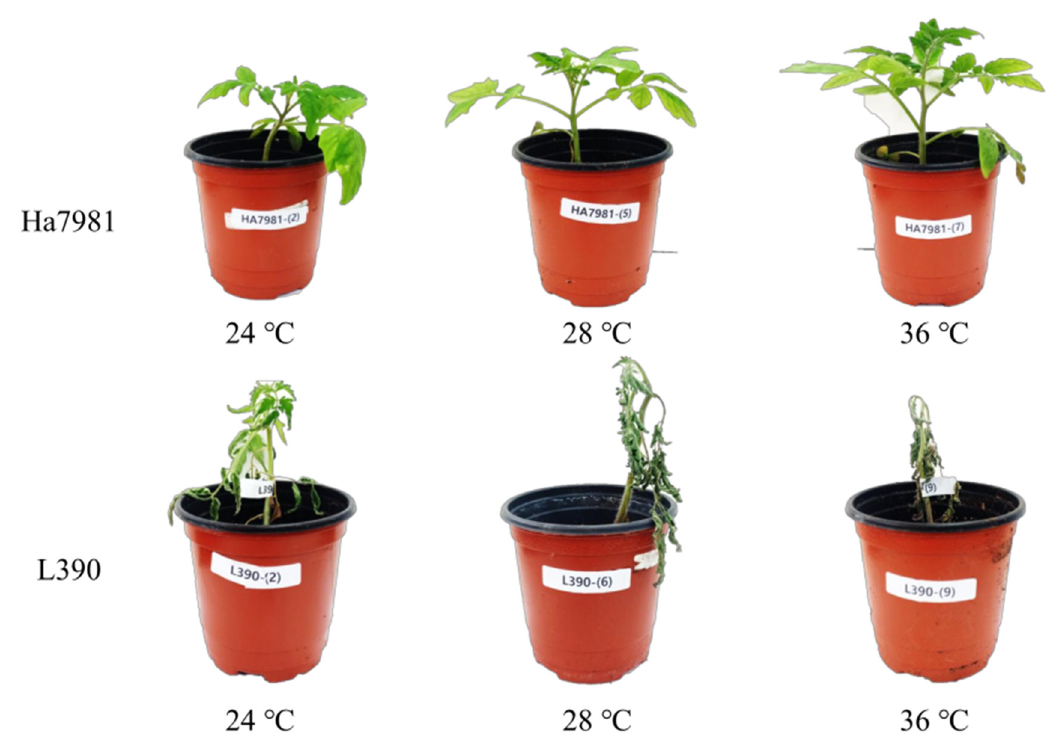
Figure 1. Disease severity of the resistance control ‘Ha7981’ and susceptible control ‘L390’ on day 7 after inoculation using the WR-1 strain (race 1, biovar 4, and phylotype I) of bacterial wilt at three different temperatures (24 °C, 28 °C, and 36 °C).